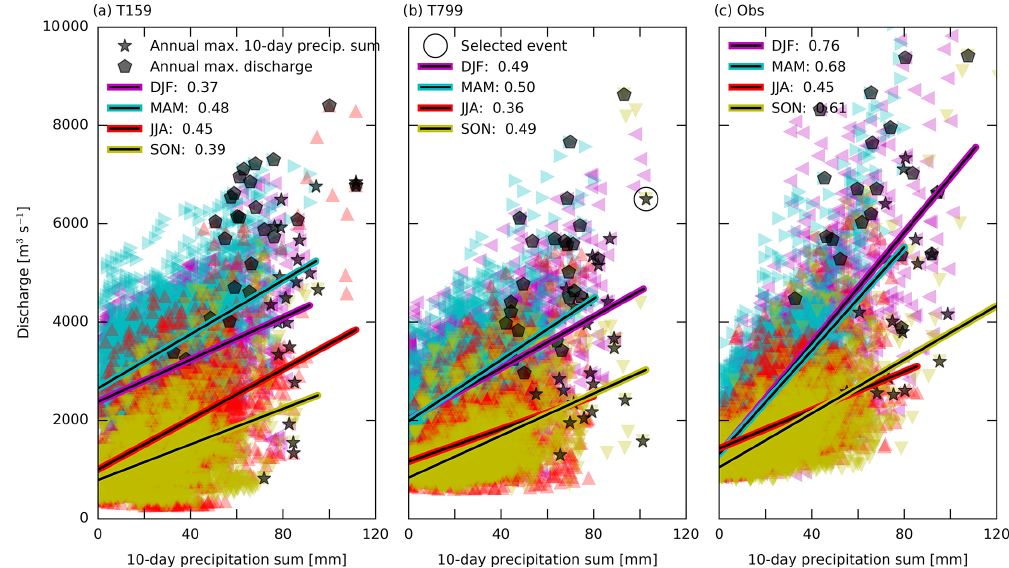
Figure 8. Scatterplot for the Rhine basin of daily discharge (m 3 s − 1 ) with previous 10-day precipitation sums (mm) for (a) the low-resolution forcing (T159), (b) the high-resolution forcing (T799), and (c) the observations (Obs.). The discharge results shown here are obtained with the 0.5 ◦ GHM. The different seasons are indicated with the colours and regression line and correlation value. The annual maxima of both 10-day precipitation sums and discharge are indicated with respectively the black stars and hexagons.